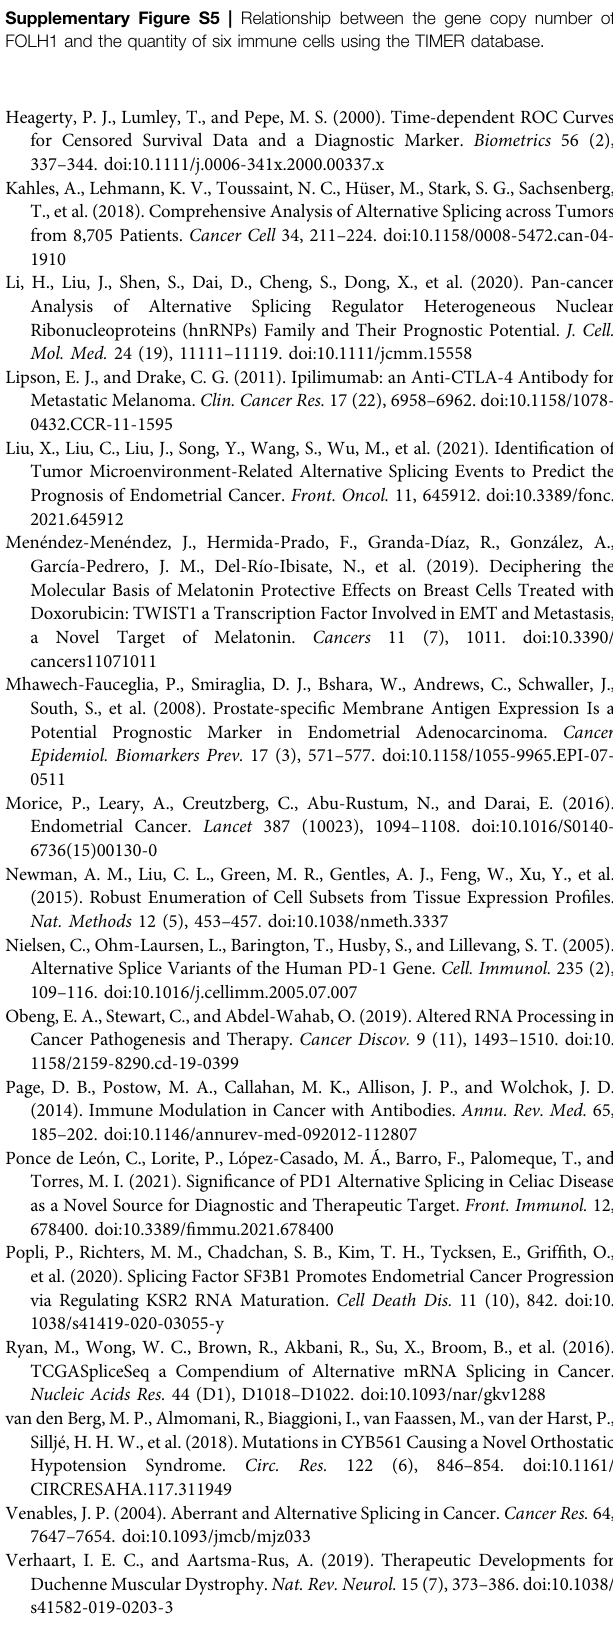
Supplementary Figure S5 | Relationship between the gene copy number of FOLH1 and the quantity of six immune cells using the TIMER